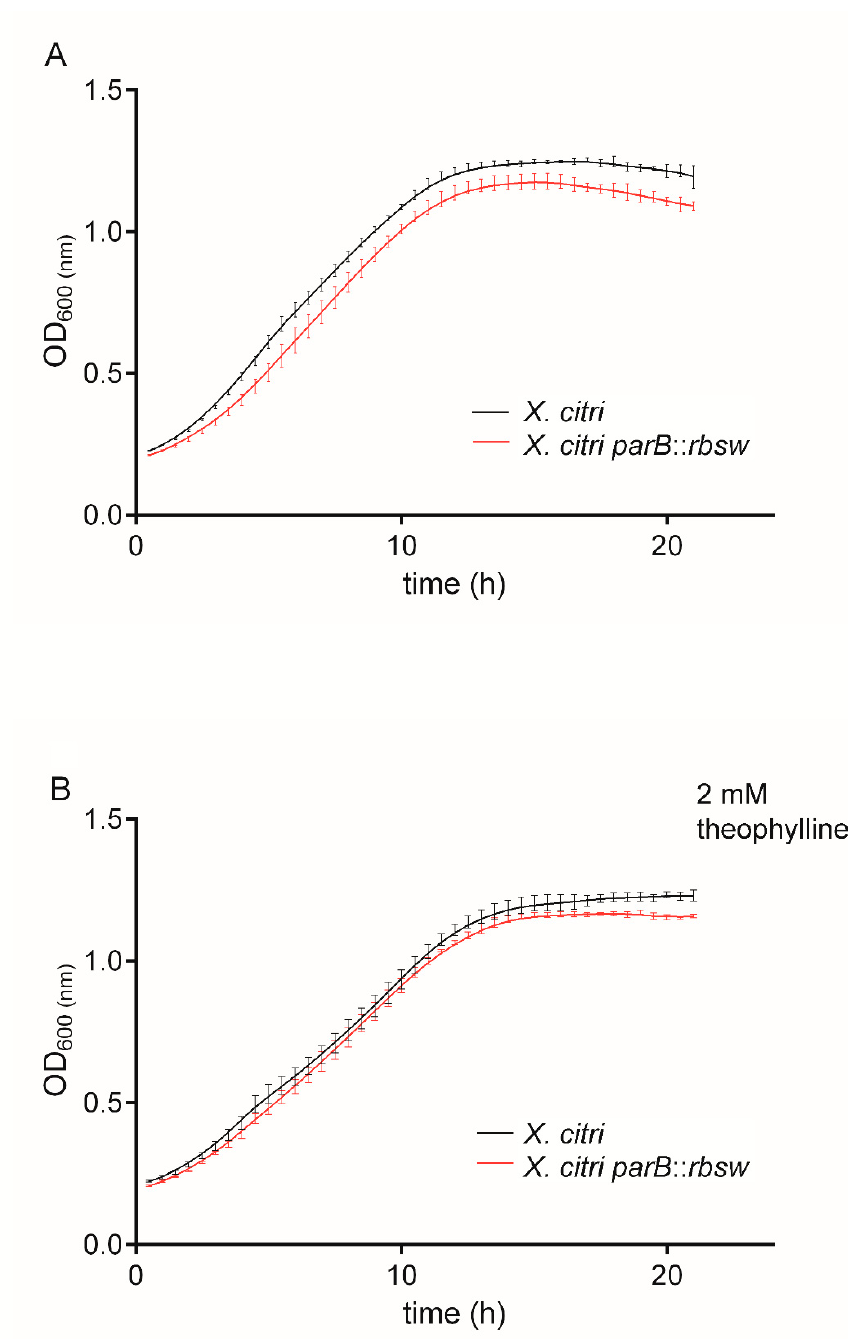
Figure 4. Xanthomonas citri mutant carrying the riboswitch theo /metE showed a normal growth pattern. Wild type X. citri and X. citri parB :: rbsw were cultivated in NYG medium from the OD600nm of ~0.1 in the absence ( A ) and presence ( B ) of 2 mM theophylline. Growth was monitored by OD600nm measurements taken every 30 min for a total period of 20 h. Here we show a representative experiment in which the points in the curves are the averages of triplicate cultures, and the vertical lines correspond to the standard deviation values of the means. Three independent experiments were performed.